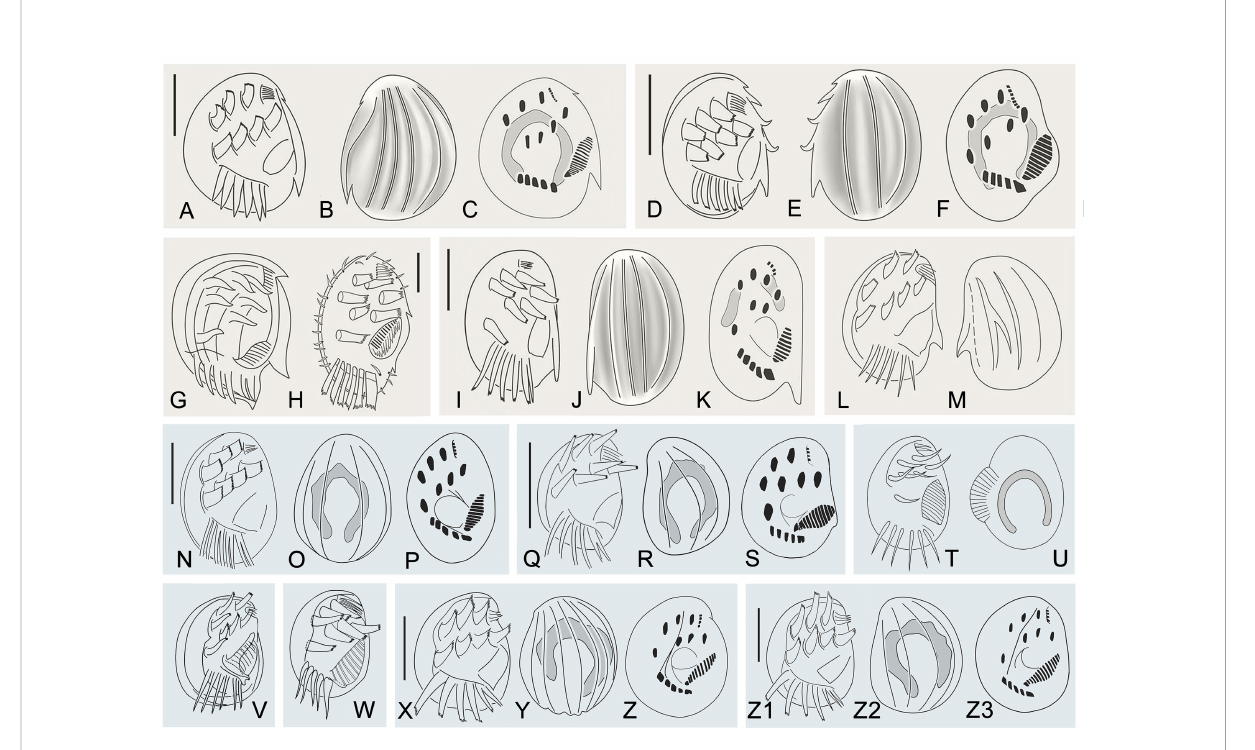
FIGURE 7 Morphological characters of Aspidisca species are similar to Aspidisca spina sp. n. (A – M) and A. shini sp. n. (N – Z3). (A – C) Aspidisca magna (redrawn after Li et al., 2010). (D – F) Aspidisca hexeris (redraw after Jiang et al., 2013). (G, H) Aspidisca sedigita (M, redrawn after Quennerstedt,